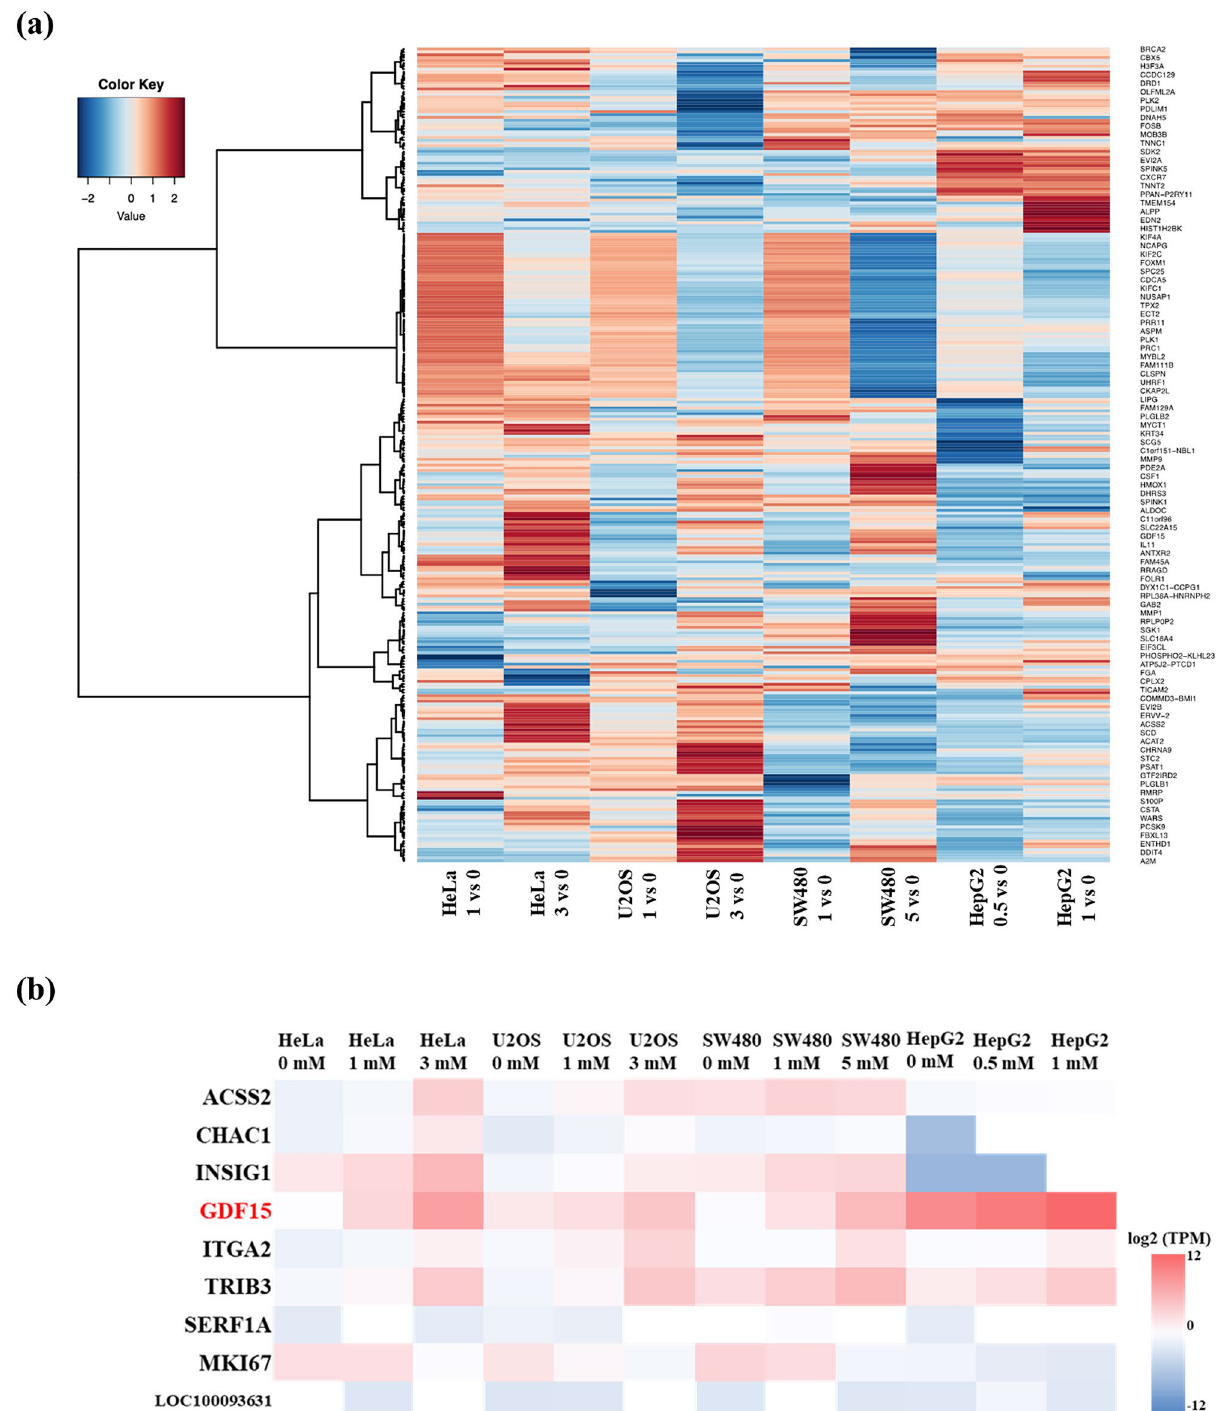
Figure 2. Transcriptome expression analysis of lidocaine-treated cancer cell lines. ( a ) Heatmap of z-scored log2 fold change values with adjusted p values of < 0.05, which were obtained from TCC-iDEGES-DESeq using the heatmap2 library on R package gplots_3.1.1 as follows: calculating z-scores, omitting “N/A” data, and hierarchical clustering with Ward’s method. Two hundred eighty-six genes had adjusted p values < 0.05 on at least one analysis. ( b ) Heatmap of commonly modified nine genes in examined cancer cell lines. The value represents the log2 fold change of transcripts per kilobase million